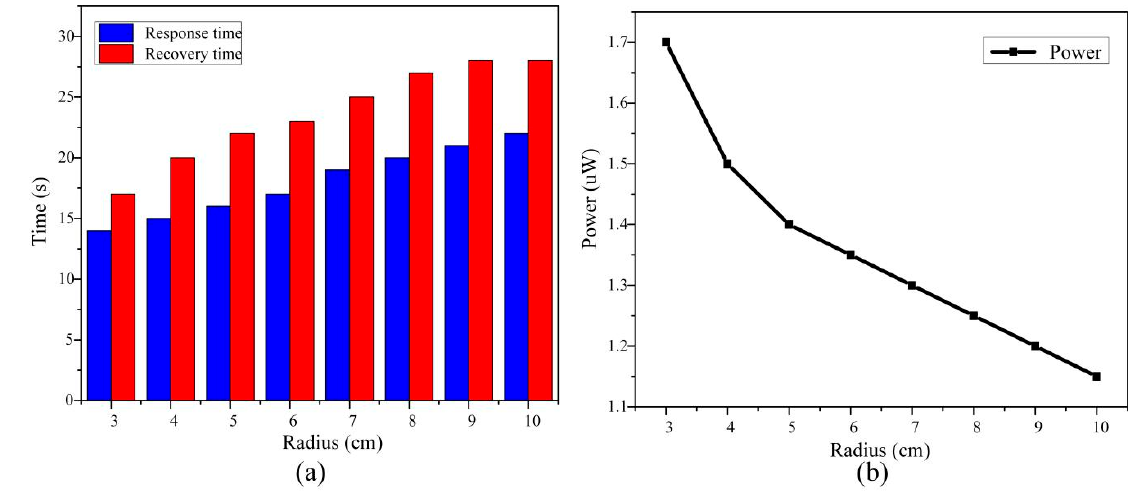
Figure 8. The POF-PPy1 at the bending radius of 3 cm to 10 cm. ( a ) Response and recovery times. ( b ) The output power.